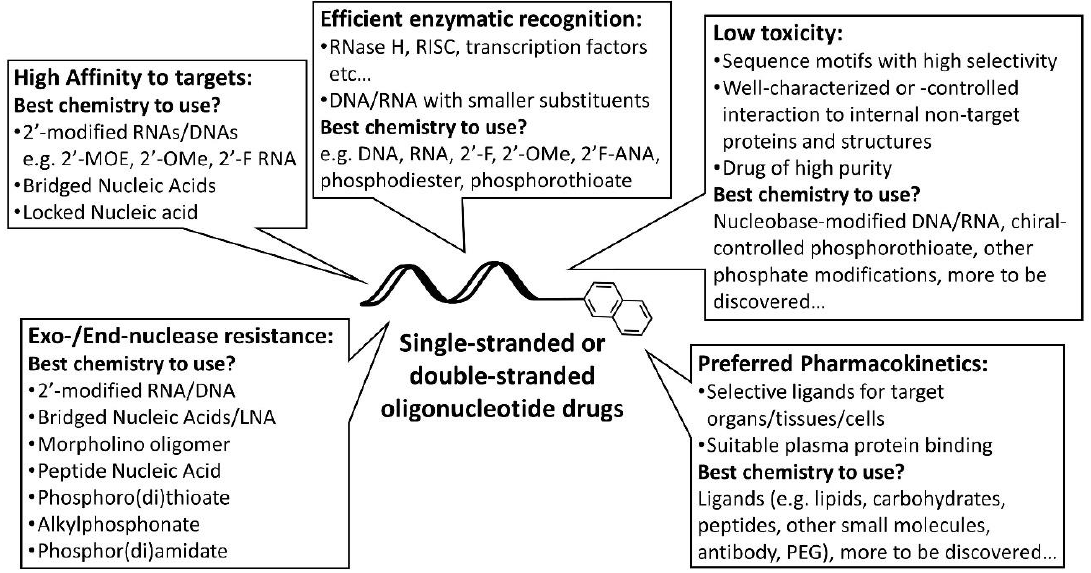
Figure 5. The information for designing ideal oligonucleotide-based drugs.